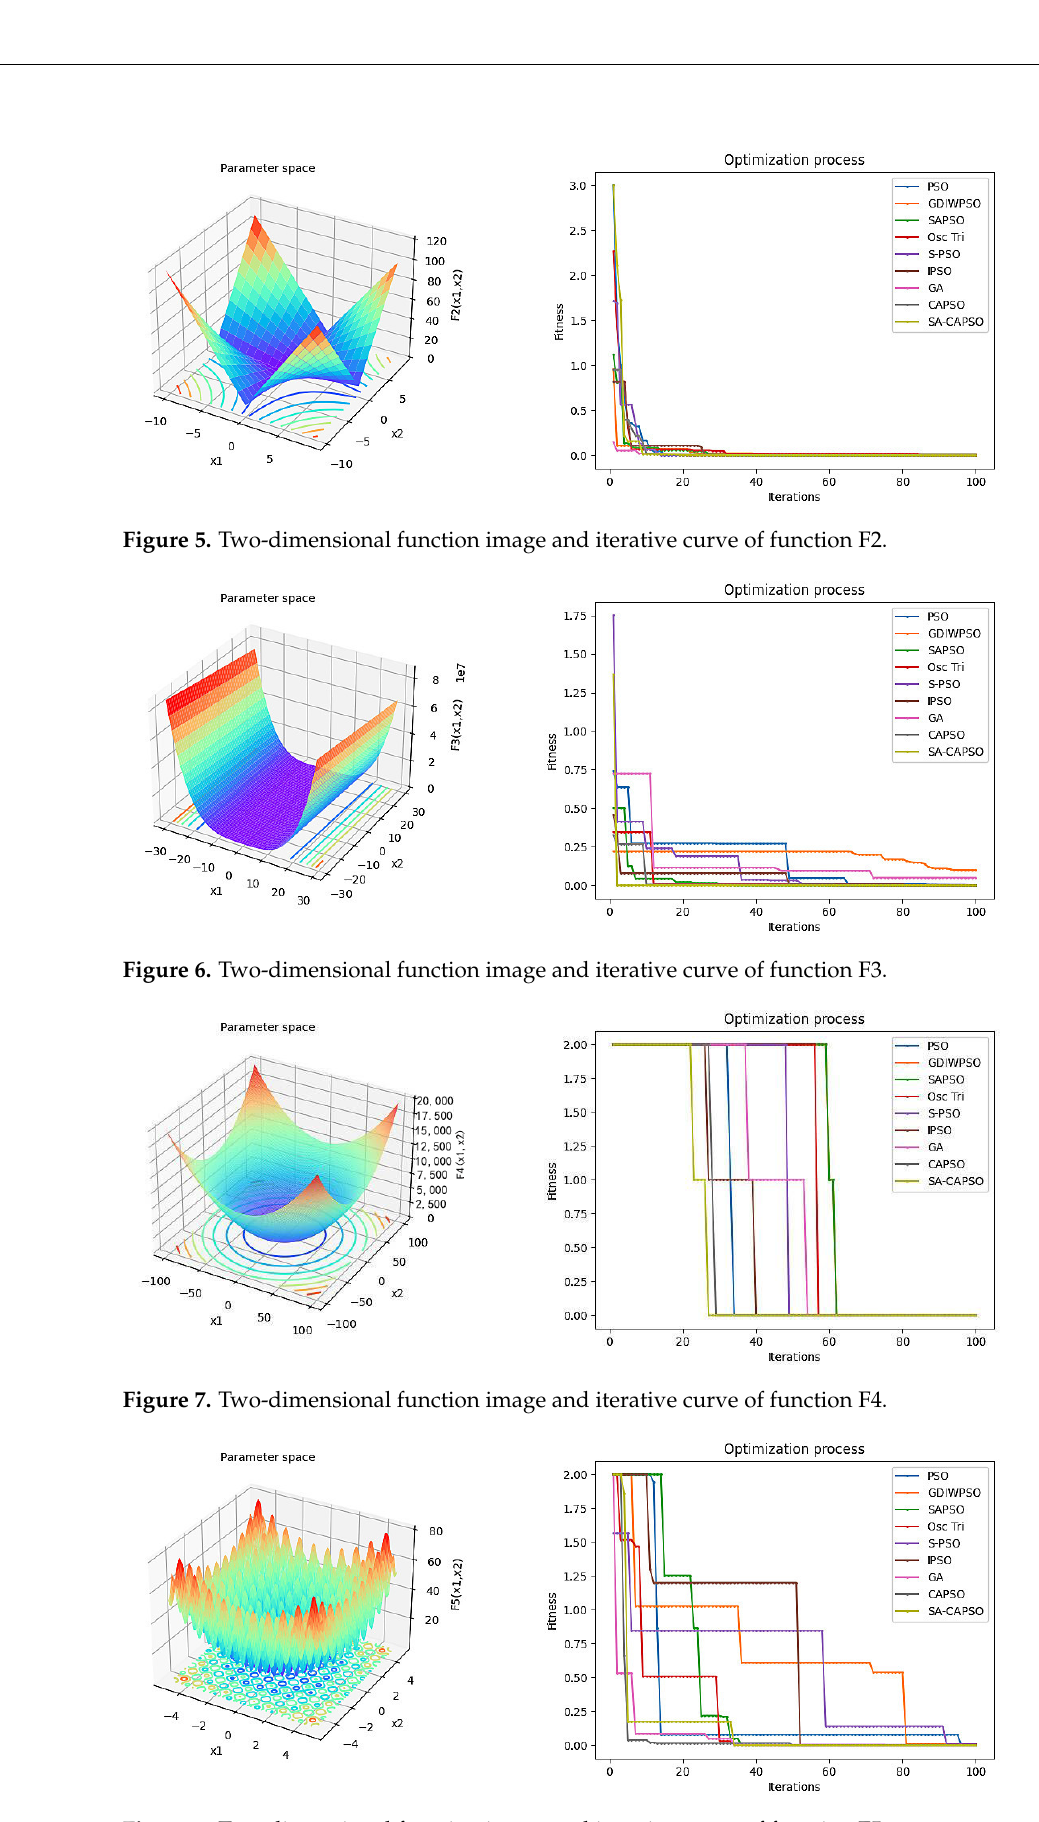
Figure 8. Two-dimensional function image and iterative curve of function